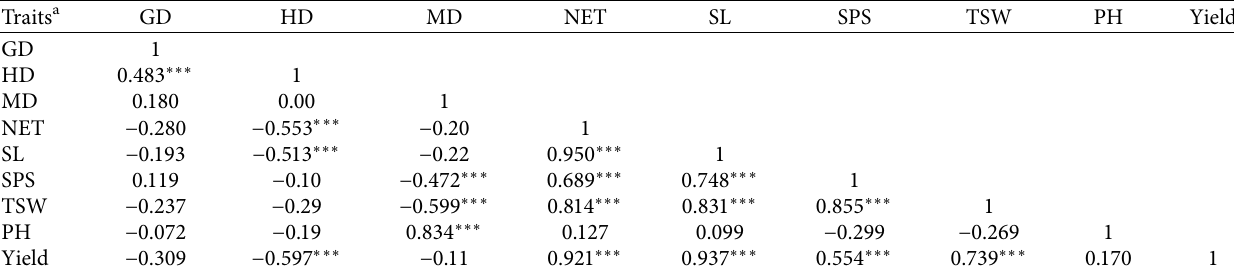
Table 5: Correlation coefficients ( r ) of barley varieties for yield and other agronomic traits. Traits a